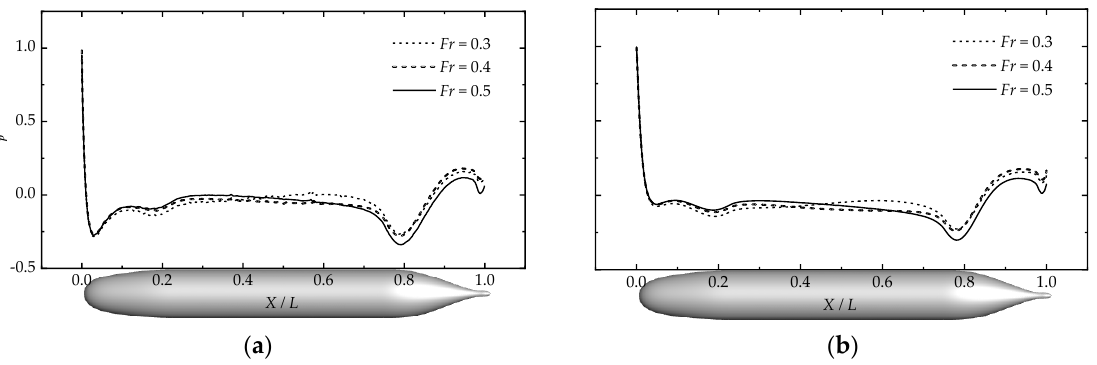
Figure 12. Pressure coefficients along the meridians of the port side and starboard side at different velocities. ( a ) Starboard side. ( b ) Port side.